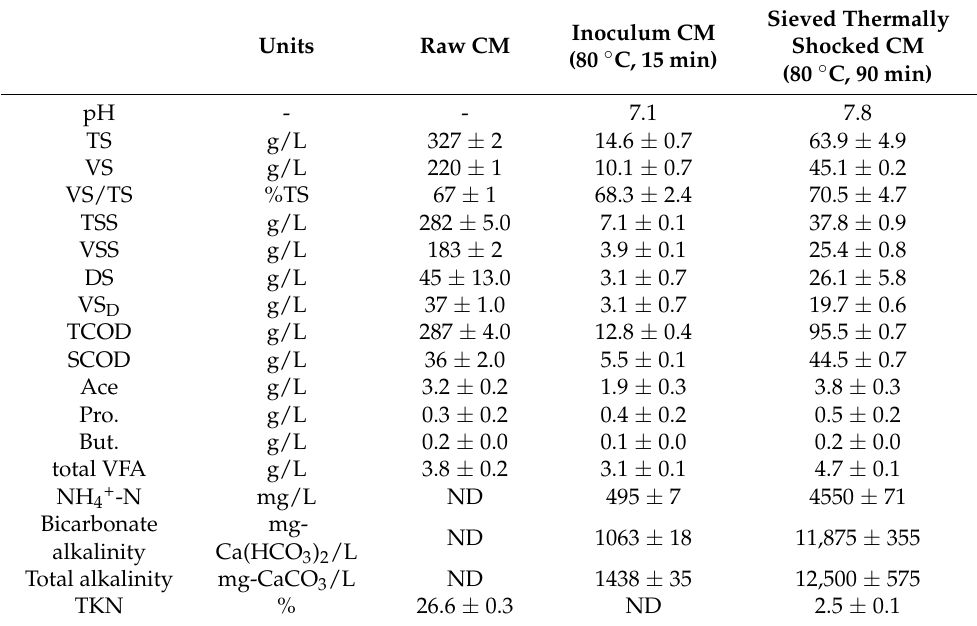
Table 1. Characteristics of raw and pretreated chicken manure as inoculum and